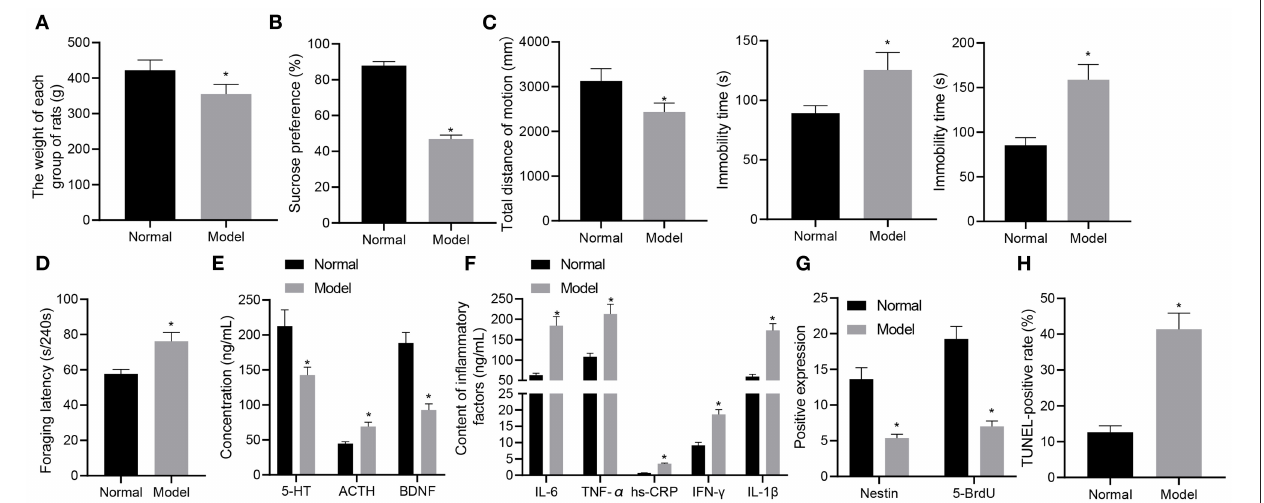
FIGURE 1 | A rat model of depression-like behaviors is successfully established. (A) weight of rats with depression-like behaviors. (B) sucrose preference in rats with depression-like behaviors. (C) total movement distance and cumulative immobility time of rats with depression-like behaviors in the forced-swimming test and tail suspension experiment. (D) latency time of food foraging of rats with depression-like behaviors. (E) 5-HT, BDNF, and ACTH levels in the serum of rats with depression-like behaviors. (F) IL-1 β , IL-6, TNF- α , hs-CRP, and IFN- γ levels in serum of rats with depression-like behaviors. (G) numbers of BrdU- and Nestin-positive cells in the hippocampus of rats with depression-like behaviors. (H) The percentage of TUNEL-positive cells in the hippocampus of rats with depression-like behaviors. * p < 0.05. n = 8.